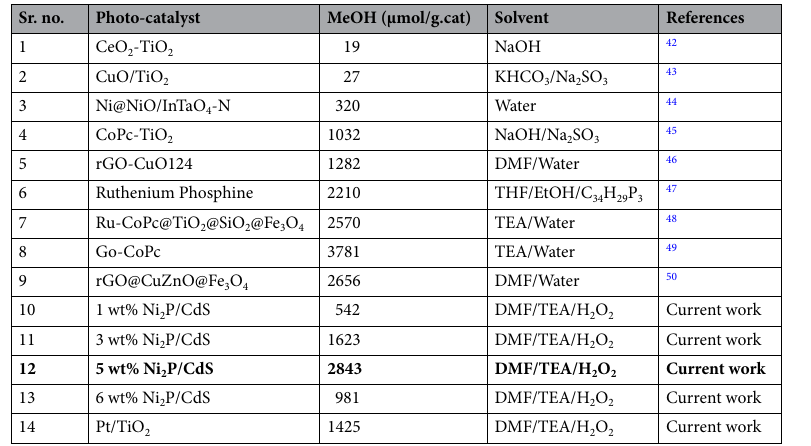
Table 2. Comparison of methanol yield over different photocatalysts. Bold is indicating present work which we are reporting in this manuscript, with significant yield.